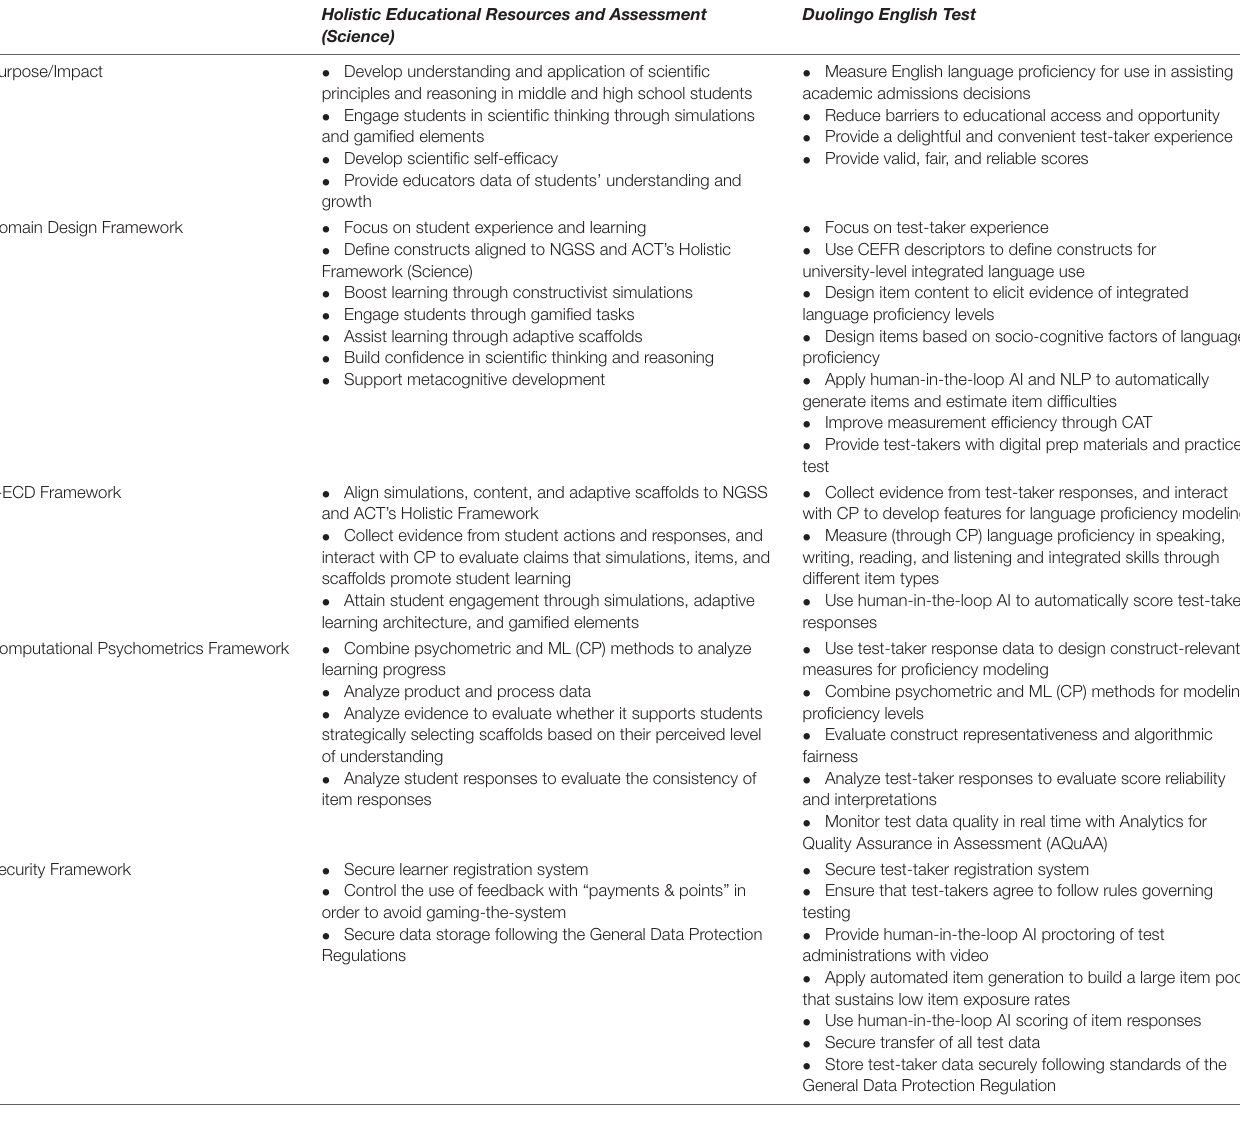
TABLE 1 | Features of the digital-first design and measurement frameworks applied to the Holistic Educational Resources and Assessment (Science) and the Duolingo English Test. Holistic Educational Resources and Assessment